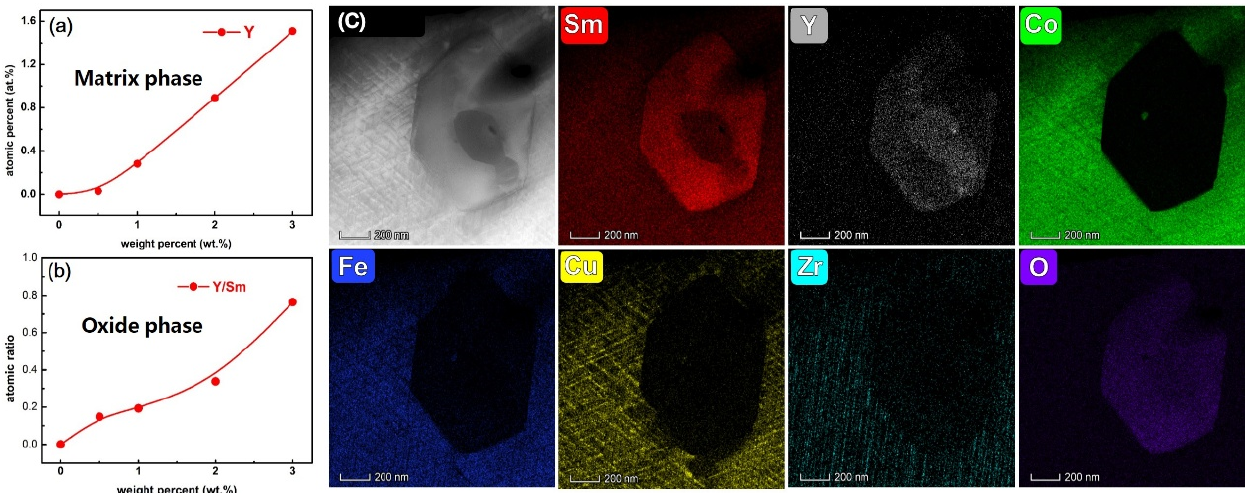
Figure 2. The SEM image of the original magnet ( a ) and EDS mapping of magnified region marked by a red dotted box ( b ), the SEM image of 0.5 wt.% doped magnet ( c ) and EDS mapping of magnified region marked by a yellow dotted box ( d ).